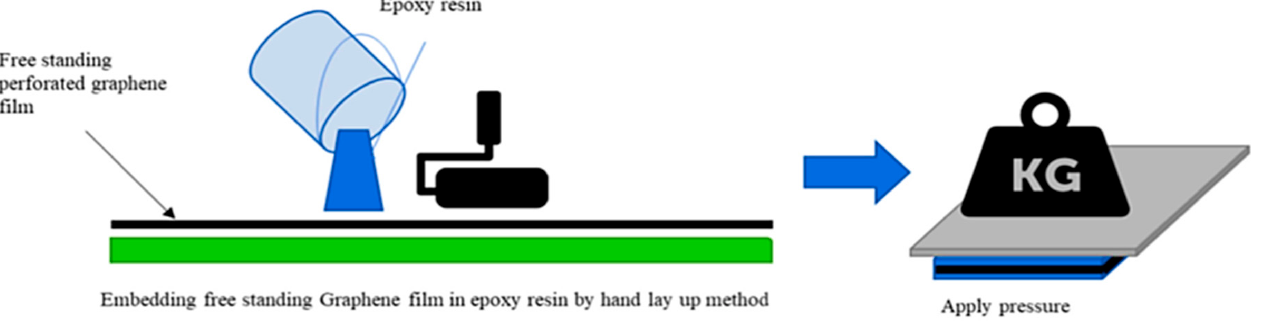
Figure 4. Fabrication process of epoxy/graphene nanocomposite. Reprinted with permission from [104]. 2020, Springer.